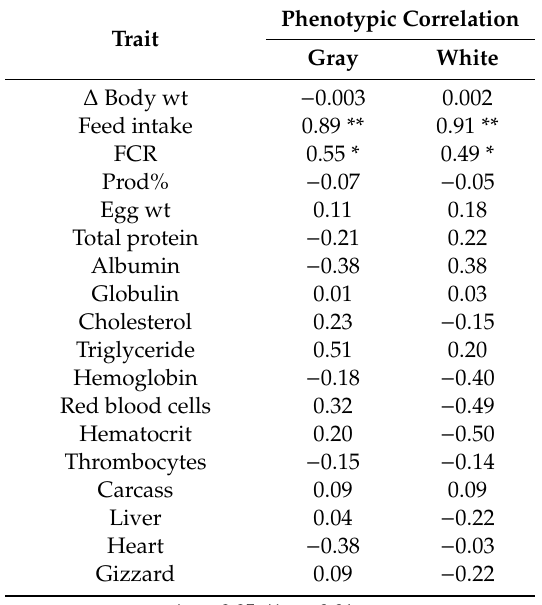
Table 6. Phenotypic correlations between RFI and some studied traits in Japanese quails. Phenotypic Correlation Trait Gray White ∆ Body